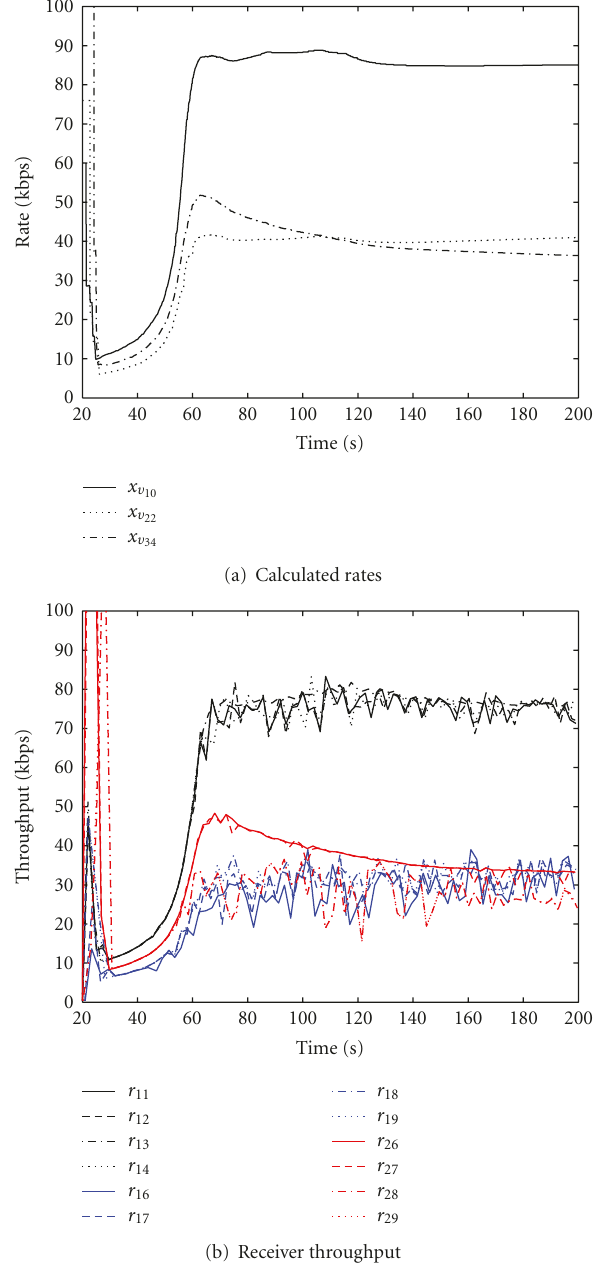
Figure 7: Convergence of ORAHWM in large random